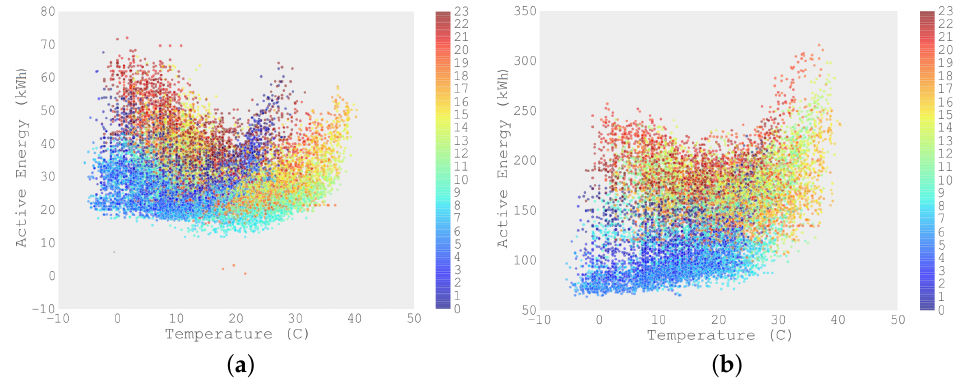
Figure 2. The correlation between active energy (kWh) and temperature ( ◦ C) for Networks 1 ( a ) and 2 ( b ). The color of each sample represents the hour of the day on which it was acquired, as coded by the color